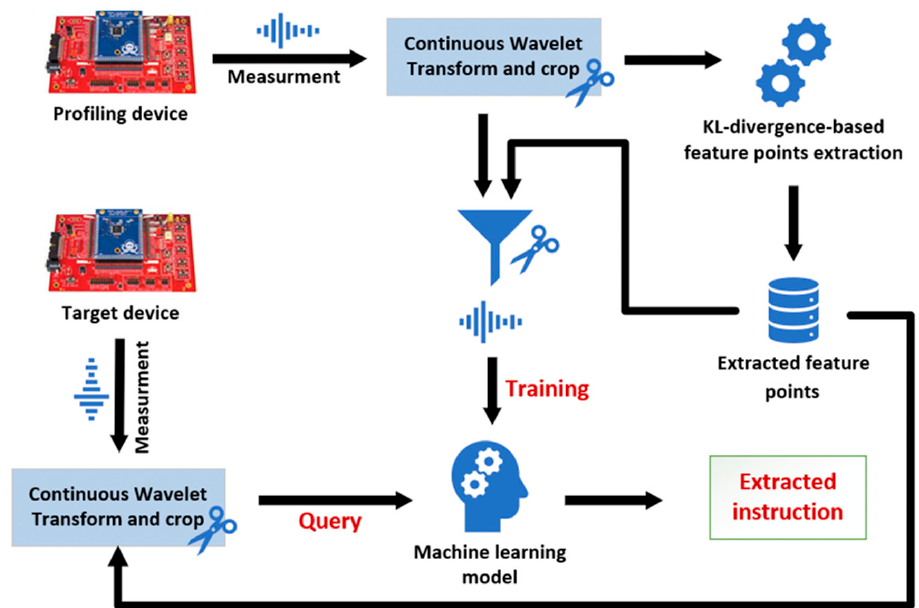
Figure 1. The overall flow of the side-channel-based disassembler.